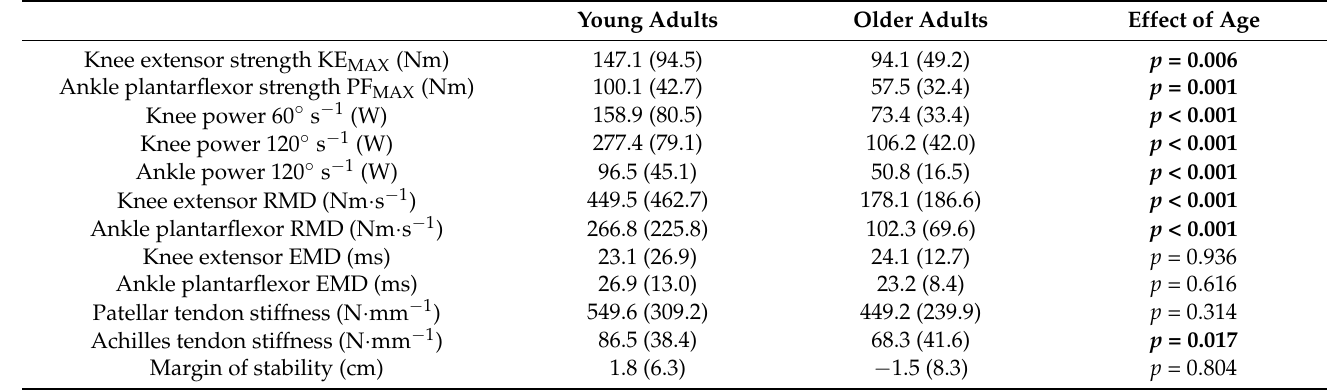
Table 2. Between group differences represented as medians (interquartile range) for young and older adults, and effect of age. Statistically significant p values in bold.